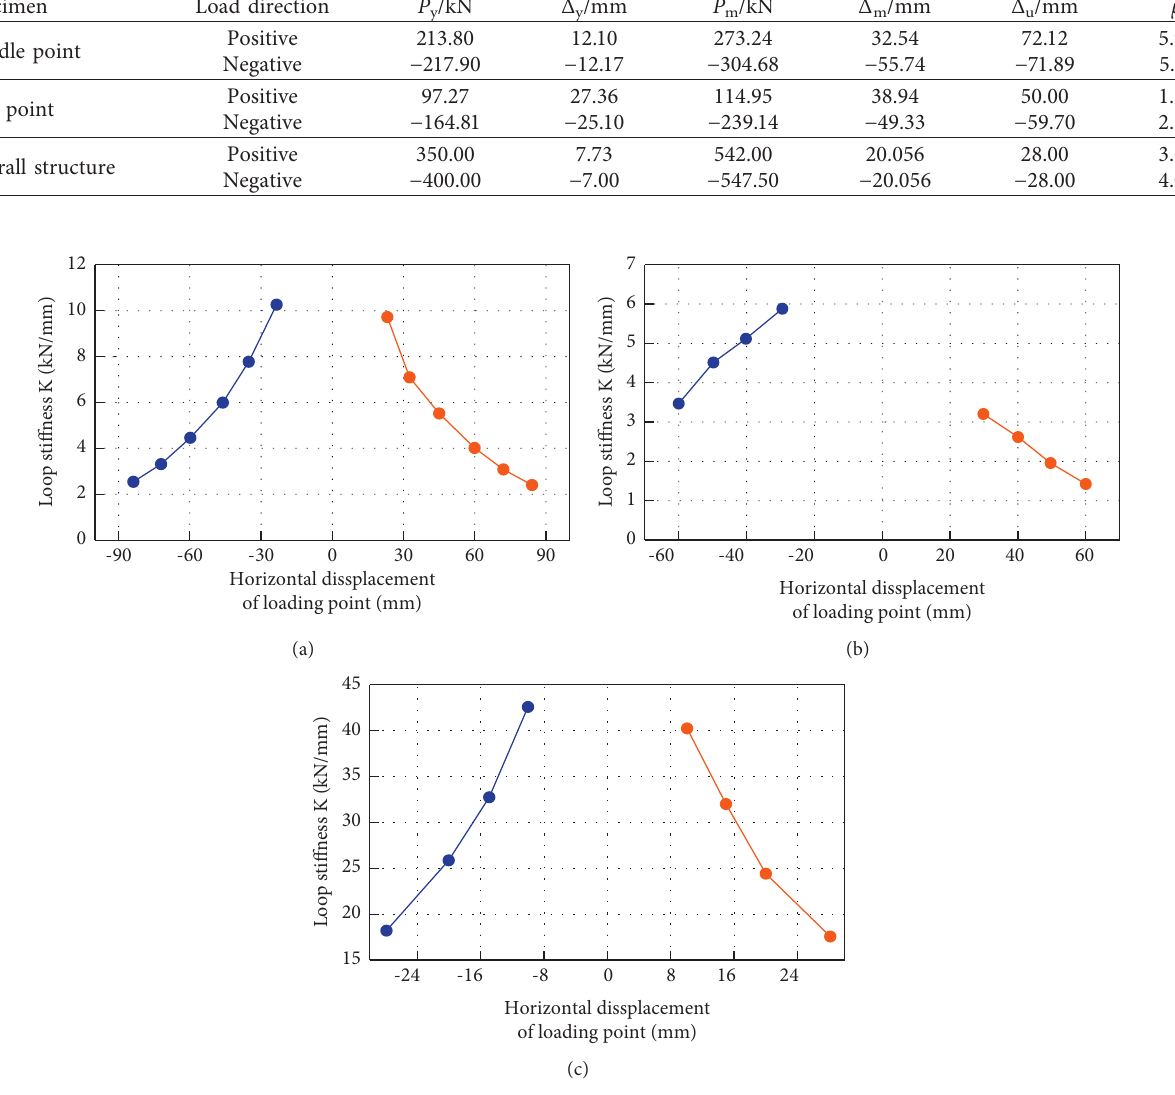
Figure 7: Stiffness degradation curve: (a) middle joint; (b) side joint; (c) overall